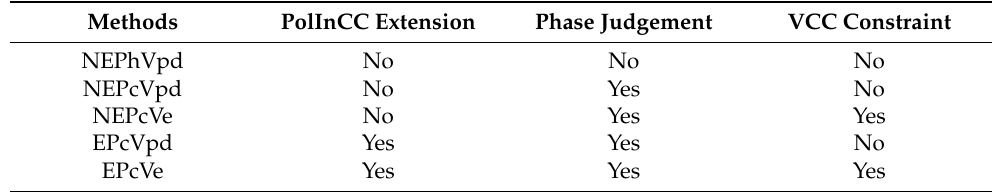
Table 1. Different forest height estimation methods for X-band data.